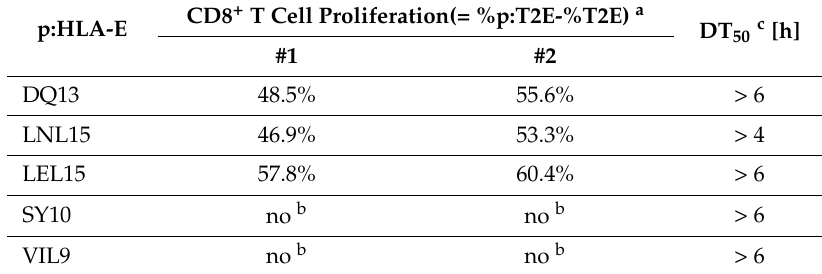
Table 2. Differences in CD8 + T cell proliferation and cell surface stability provoked by p:HLA-E